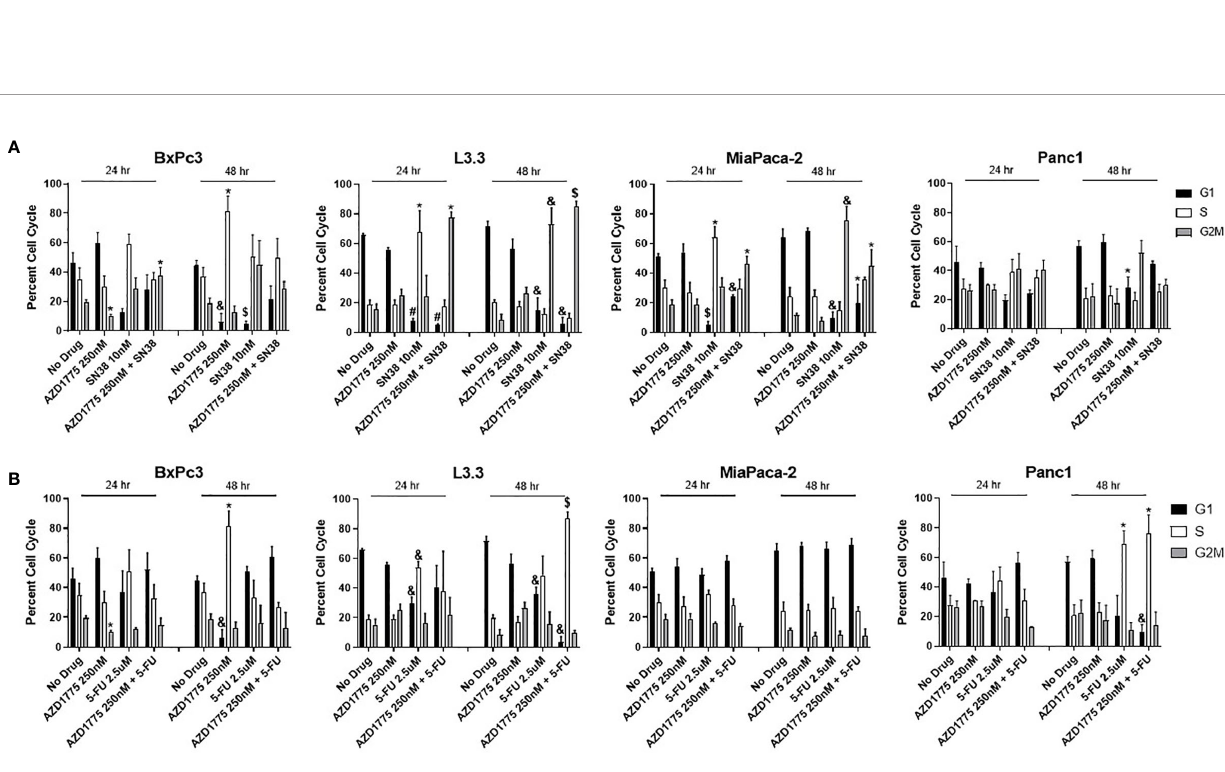
FIGURE 5 | Cell cycle analysis of AZD1775 (250 nM) and (A) SN38 or (B) 5-FU in PDAC cell lines. Cells were treated with AZD1775 and SN38 or 5-FU for 24 and 48 hours, then cell cycle arrest was assessed using Krishan ’ s stain followed by fl ow cytometry. Data were analyzed with a t-test to compare single agents to the combination (* = p ≤ 0.05, & = p ≤ 0.01, $ = p ≤ 0.001, # = p ≤